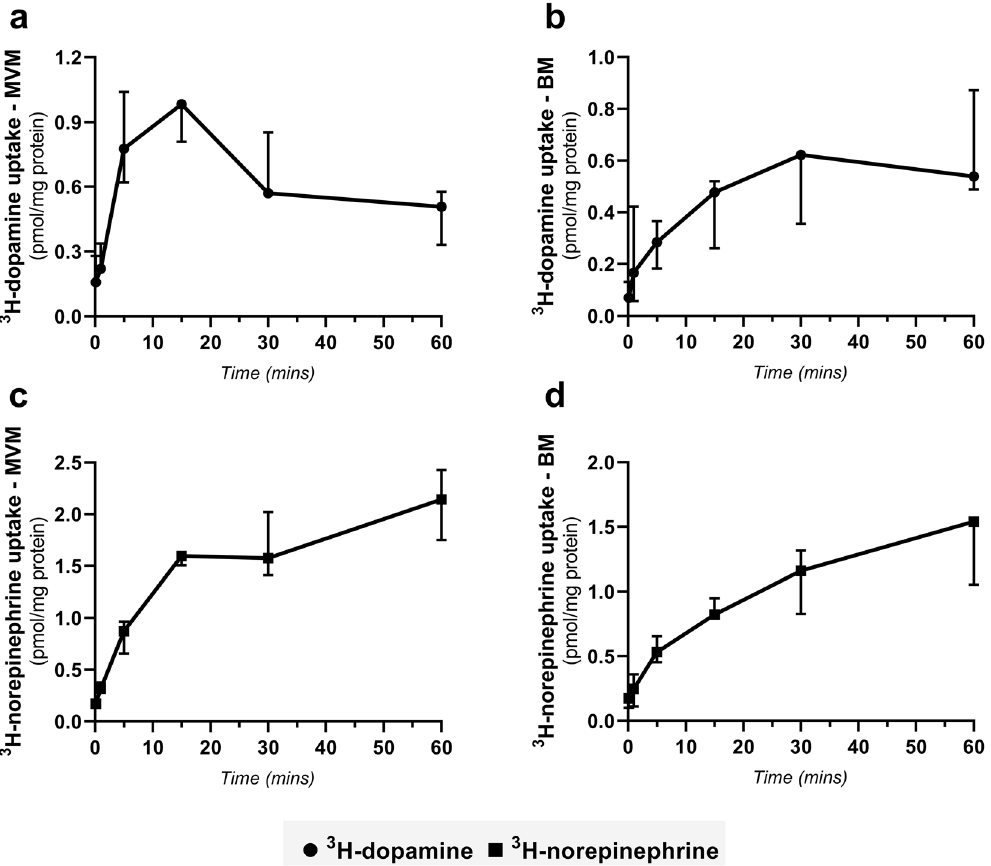
Figure 1. Time-course of 3 H-dopamine and 3 H-norepinephrine uptake into MVM and BM vesicles isolated from human term placenta. Vesicle fractions were incubated at room temperature with 112 nM 3 H-dopamine ( a , b ) and 332 nM 3 H-norepinephrine ( c , d ), pH 7.4. The vesicular uptake is presented as pmol/mg protein, and data are shown as median with interquartile range, n =